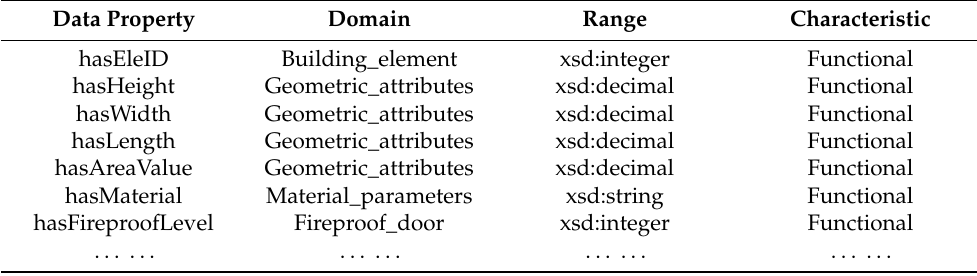
Table 4. Definition of data properties of the DFS ontology.